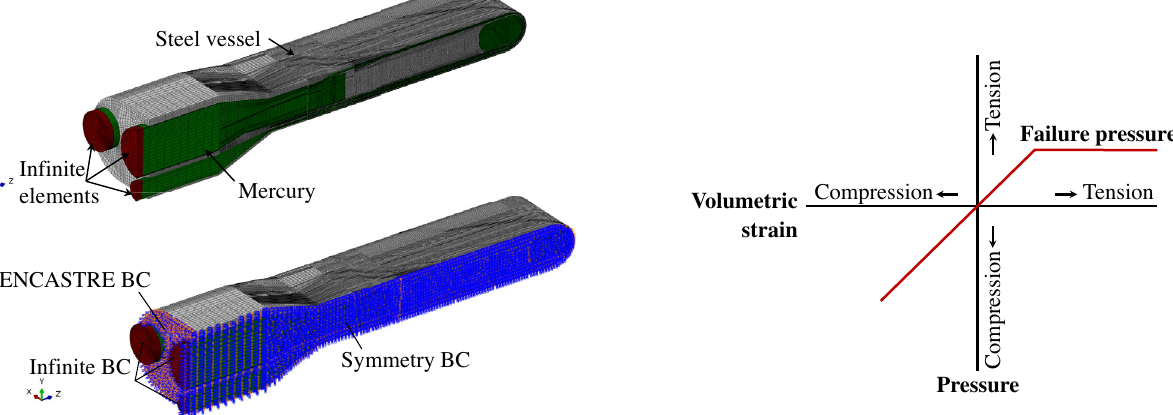
FIG. 3. Target FEA simulation model.